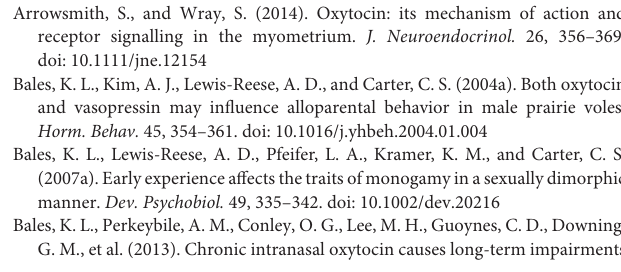
The full array of unique features seen in social monogamy is observed in only a small fraction of mammalian